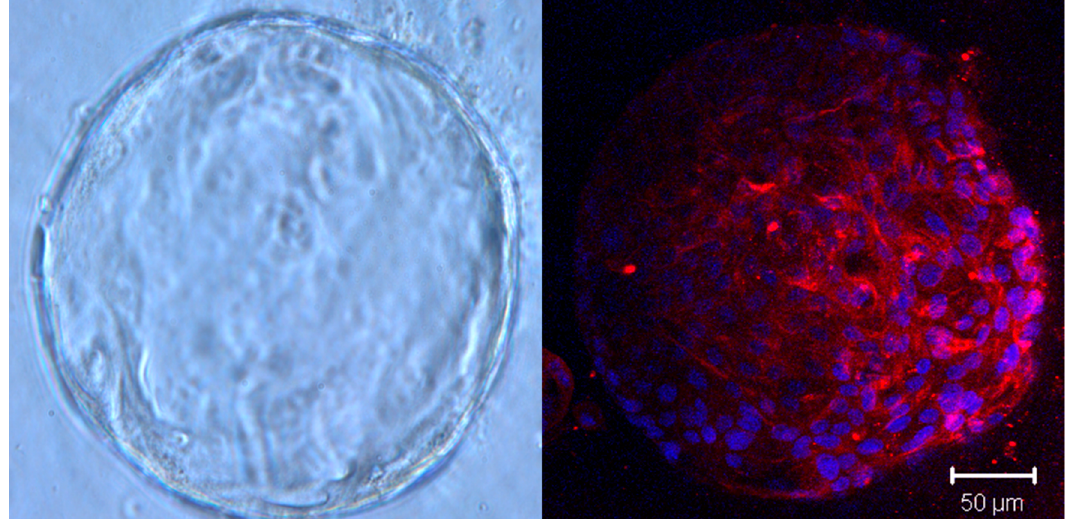
Figure 2. Brightfield image of a single P3 PDAC organoid (magnification, 200×) and expression of fibroblast-associated protein (red) in the same organoid line. DAPI was used for nuclear counterstaining and immunoflourescence was visualized with confocal microscopy (Zeiss 510 Meta NLO).